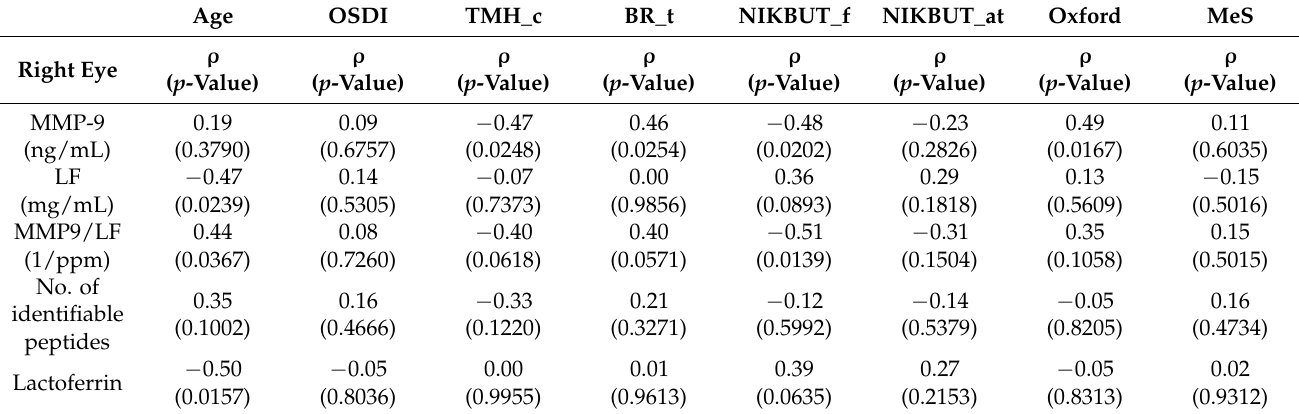
Table 2. Association between ocular surface homeostasis and tear biomarkers in the ipsilateral